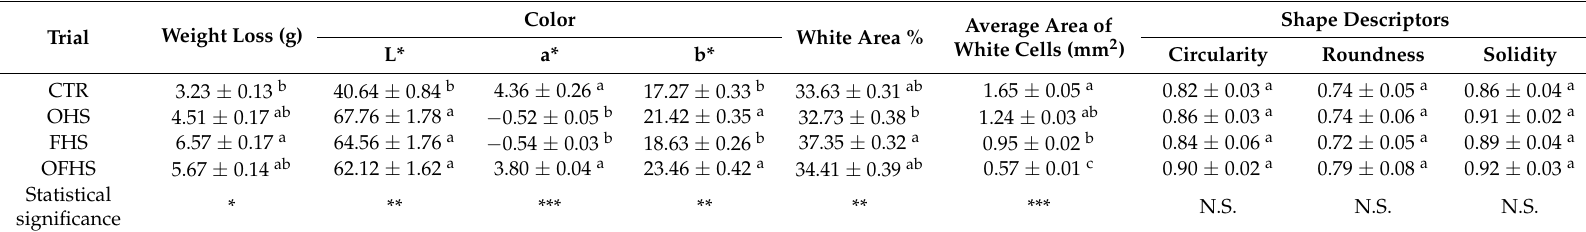
Table 2. Characteristics of unseasoned